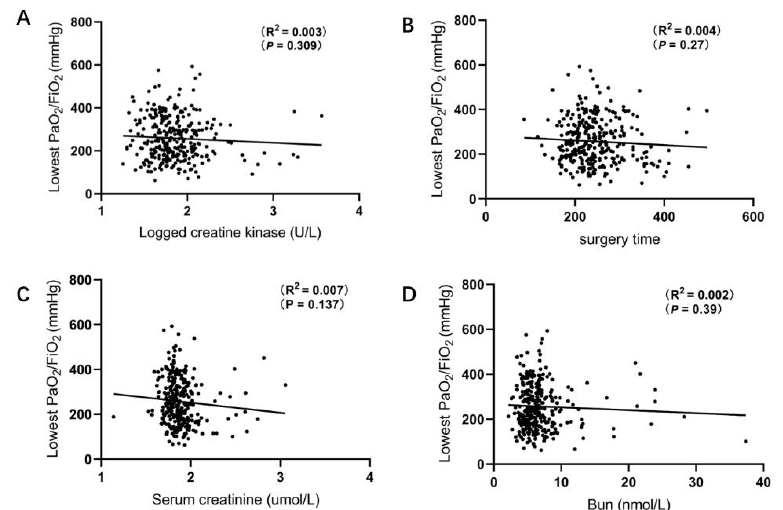
Figure 2. The correlation between lowest postoperative PaO 2 /FiO 2 levels and baseline characteristics. Postoperative PaO 2 /FiO 2 was not correlated with ( A ) Creatine kinase (r 2 = 0.003; p = 0.309), ( B ) Surgery time (r 2 = 0.004; p = 0.27), ( C ) Creatinine (r 2 = 0.007; p = 0.137), ( D ) Bun levels (r 2 = 0.002, p = 0.39).